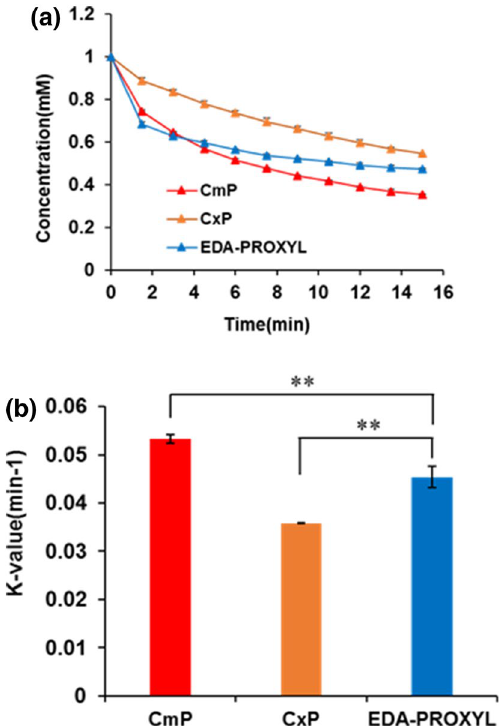
Figure 2. ( a ) Temporal changes in the radical concentrations of carbamoyl PROXYL, carboxyl PROXYL, and EDA-PROXYL due to reduction by ascorbic acid over the time course of 1 to 15 min. Data are presented as mean ± standard deviation (n = 3 per group). ( b ) Reduction rates of the three probes through reaction with ascorbic acid over the time course of 1 to 15 min. Data are presented as mean ± standard deviation (n = 3 per group). * p < 0.05; ** p <